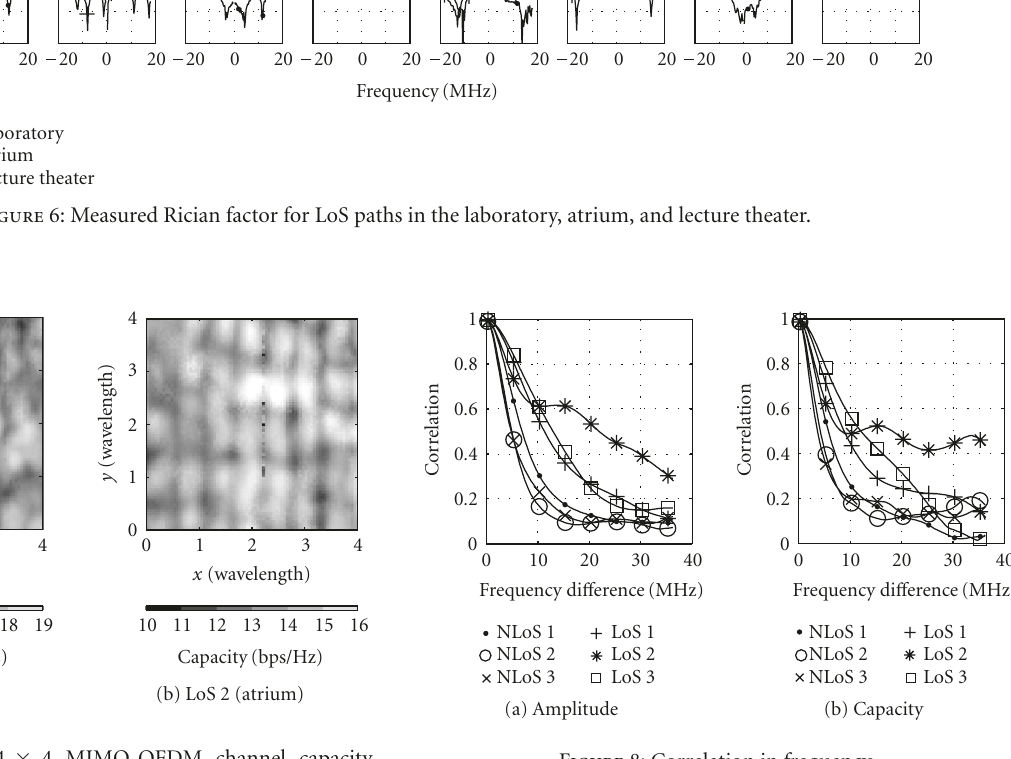
Figure 8: Correlation in